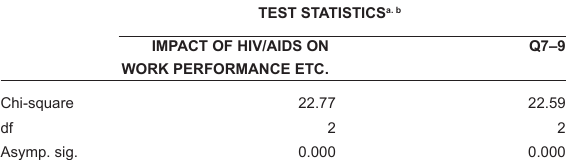
TABLE 12 Test statistics of the Kruskal-Wallis test (questions 7–9) TEST STATISTICS a. b